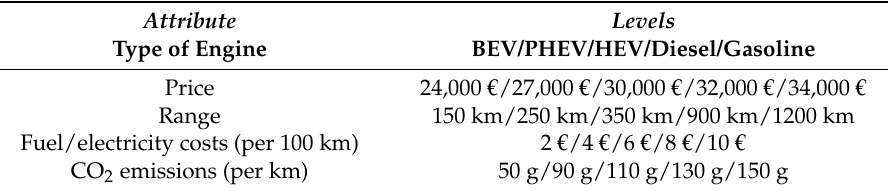
Table 3. Levels for each attribute.